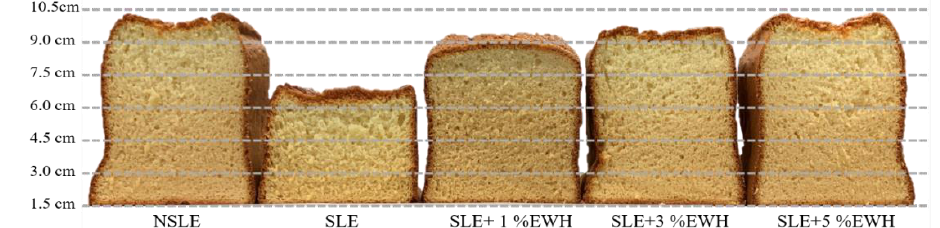
Figure 4. Cross-sectional heights of cakes made with non-sterilized liquid egg white (NSLE), sterilized liquid egg white (SLE), and SLE supplemented with 1%, 3%, or 5% egg white hydrolysate